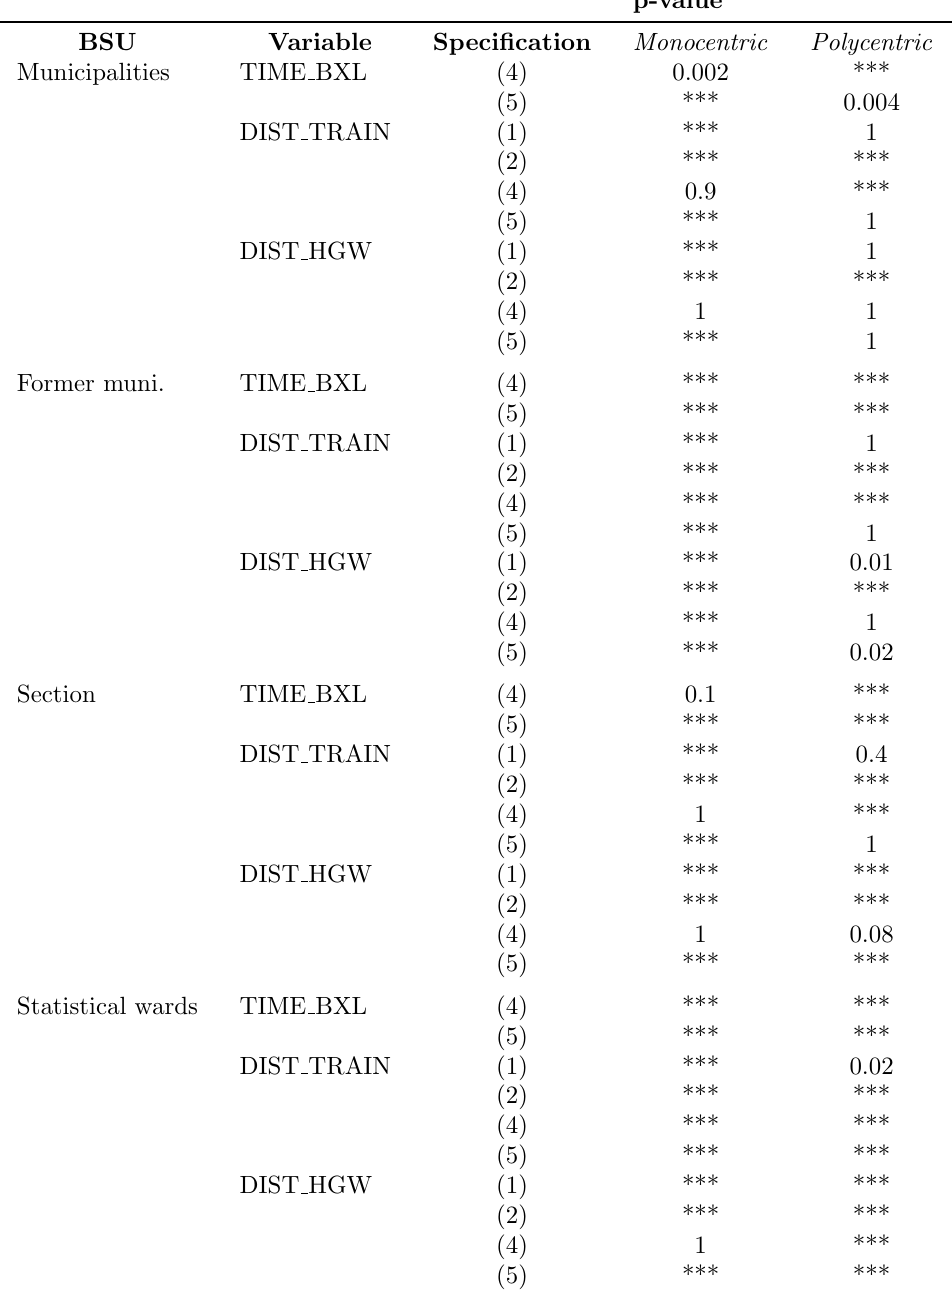
Table A.2: Pairwise t-test comparison of parameter estimates between the benchmark model and control specifications (*** = significant at alpha = 0.001; Bonferroni adjustment of